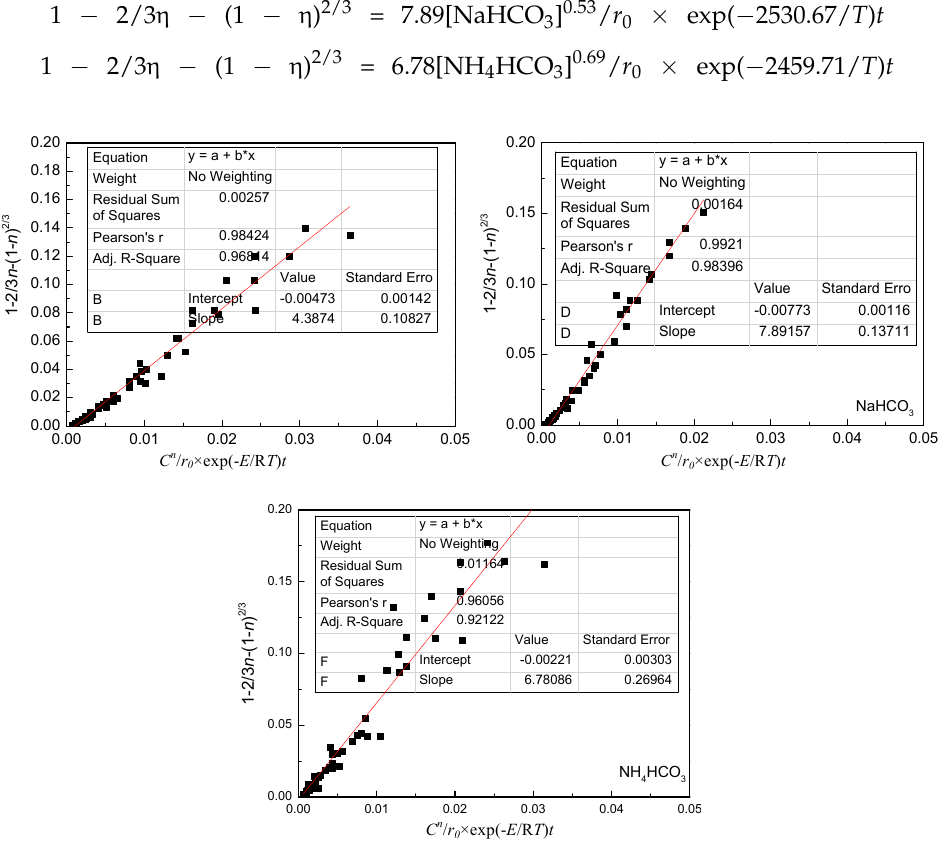
Figure 14. The relation between 1 − 2/3 η − (1 − η ) 2/3 and C n / r 0 × exp( − E /R T ) t in the solutions for the carbonation of calcium metavanadate.